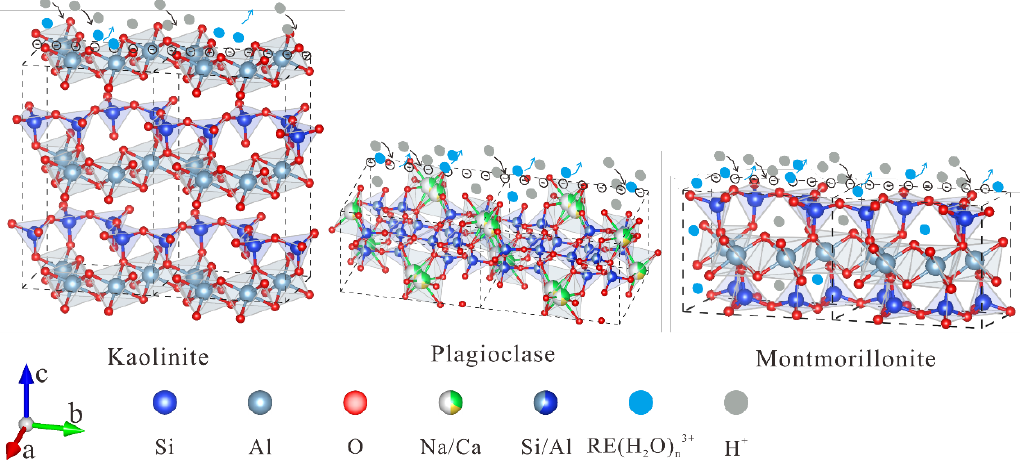
Figure 9. Mineral crystal structure and ion exchange process .